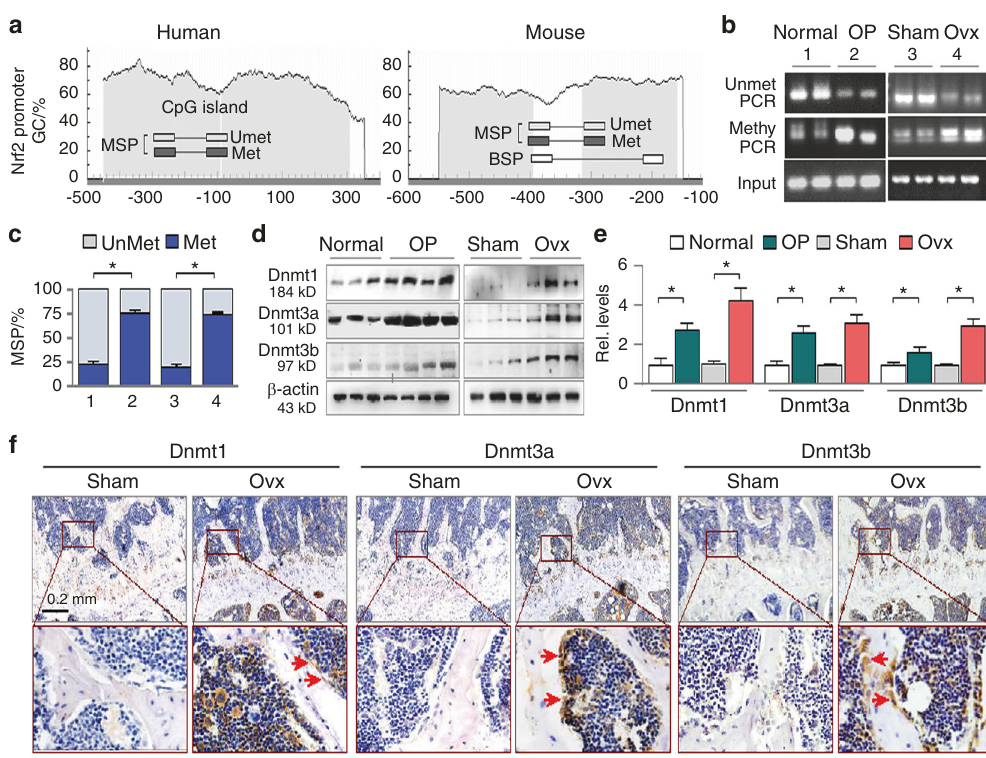
Fig. 2 The Nrf2 promoter is hypermethylated in the femurs of osteoporotic patients and ovariectomized mice. a Schematic diagrams of human and murine Nrf2 promoters. The positions of CpG islands (gray area) and MSP/BSP primers are depicted relative to the transcription start site. b Representative agarose gel analyses of MSP products (methylated, unmethylated and input PCR) from the femurs of 4 control individuals and 3 patients with OP (the left panel) and the sham or ovariectomized mice (the right panel, 5 weeks after Ovx, 6 mice in each group, two representative samples are shown). c Quanti fi cations of MSPs of Fig. 2b. Values are presented as percentage ± SEM of methylated/unmethylated PCR over total PCR products after adjustment with input controls from all human samples and experimental mice. * P < 0.05, one-way ANOVA. d Western blots of femoral Dnmt1, Dnmt3a, and Dnmt3b from human and mouse femurs (three randomly selected mouse samples are shown). e Quanti fi cations of Fig. 2d. * P <0.05, one-way ANOVA. f Representative mouse femur sections stained for Dnmt1, Dnmt3a, and Dnmt3b by immunohistochemistry (IHC). The lower panel images are the enlarged frames of the upper panel. The positively stained cells in brown are indicated by arrows